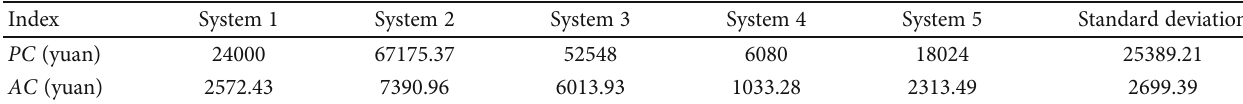
Table 8: Economy of the di ff erent biogas heating